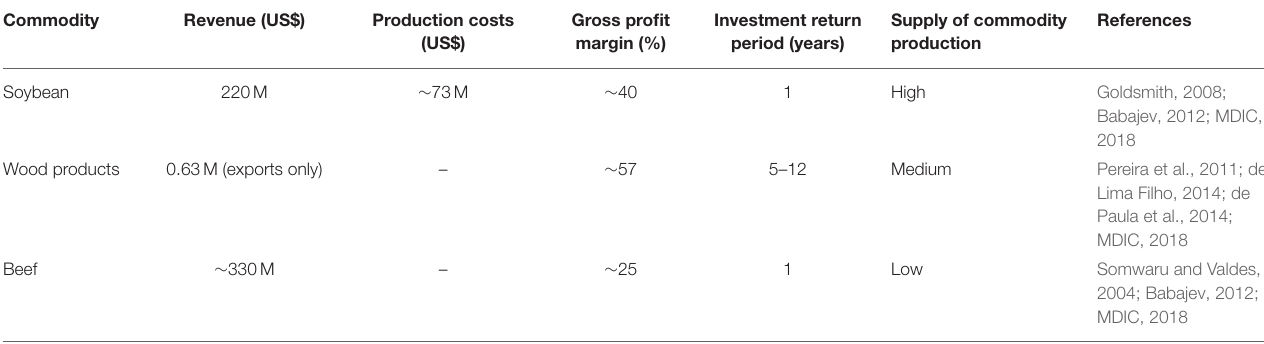
TABLE 2 | Estimated revenue, production costs, gross profit margin, investment return periods, and relative level of production supply for the main commodities in Paragominas for the 2004–2018